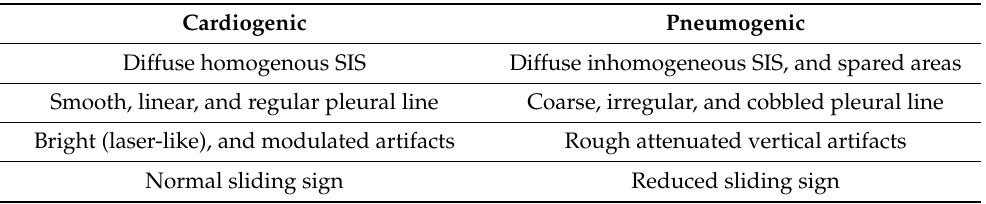
Table 1. Differences between acute cardiogenic pulmonary edema (ACPE) and ARDS (pneumogenic) sonographic interstitial syndrome (SIS). Cardiogenic Pneumogenic Diffuse homogenous SIS Diffuse inhomogeneous SIS, and spared areas Smooth, linear, and regular pleural line Coarse, irregular, and cobbled pleural line Bright (laser-like), and modulated artifacts Rough attenuated vertical artifacts Normal sliding sign Reduced sliding